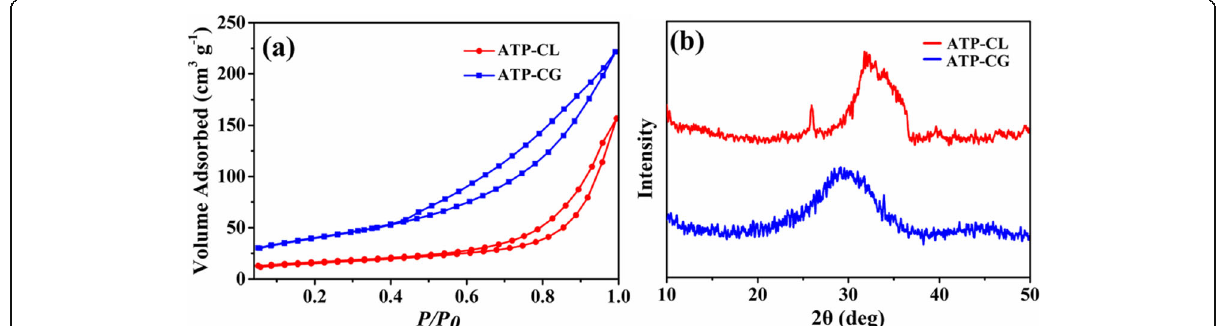
Fig. 11 a Nitrogen adsorption-desorption isotherms. b XRD patterns of microspheres